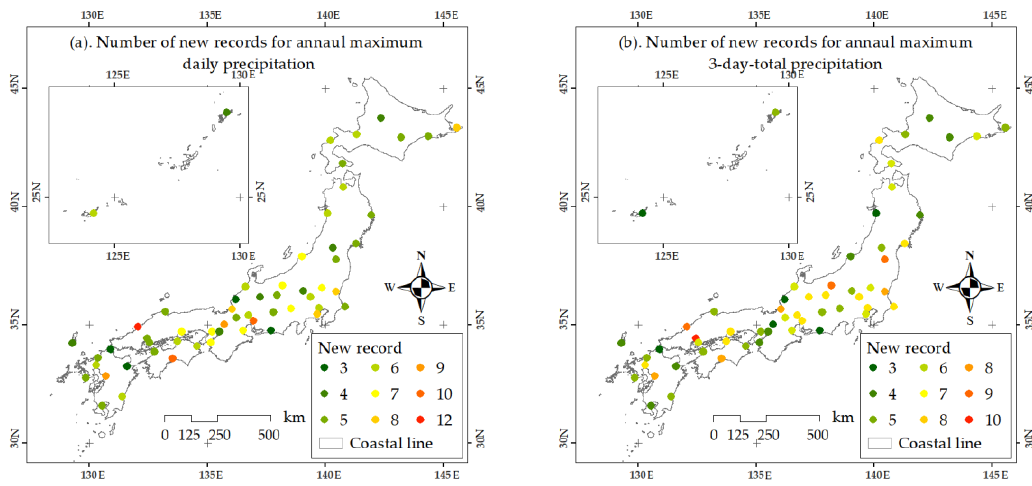
Figure 3. Amount of new records for annual maximum ( a ) daily precipitation and ( b ) 3-day total precipitation of the 58 rain gauges in Japan. Colors indicate the numbers of new records for annual maximum daily and 3-day total precipitation, respectively.